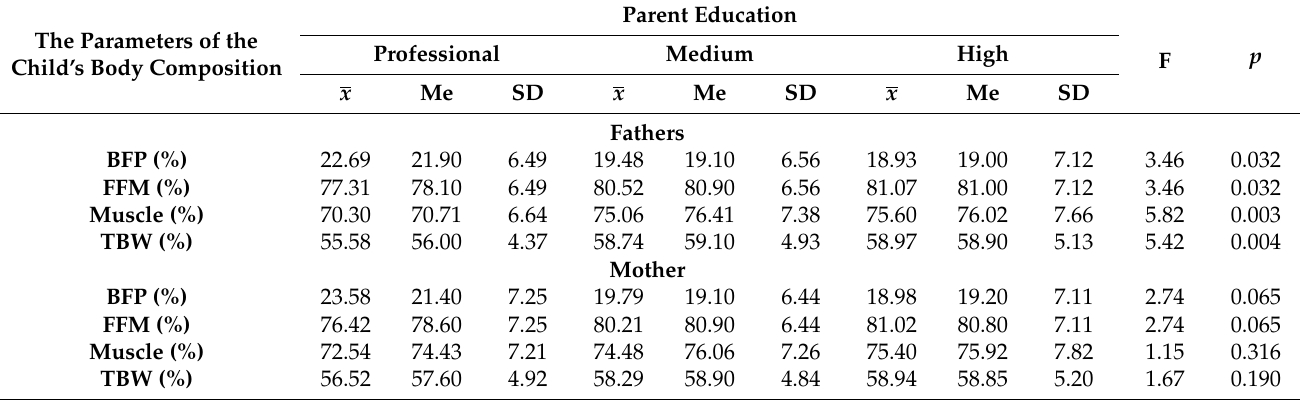
Table 6. Differences in the composition of body weight depending on the parent’s education of the